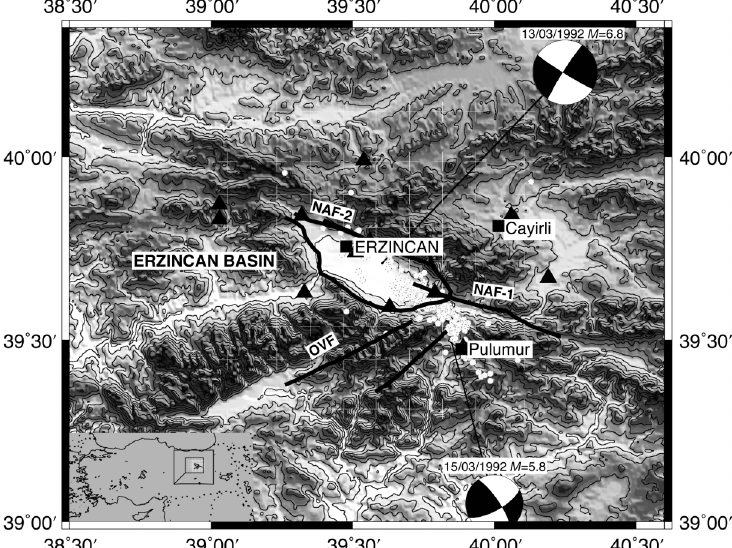
Fig. 1. Topographic map showing the Erzincan Basin and surrounding area. NAFZ, North Anatolian Fault Zone; OVF, Ovacik Fault. Epicenters (solid white circles) of the aftershocks of the 1992 March 13th Erzincan earthquake located by a temporary local seismic network (solid triangles). The focal mechanism for the Erzin- can earthquake and the largest aftershock (occurred near the Pülümür town) are taken from Fuenzalida et al. (1997). Hatched area denotes the study region and the grid net used in the inversion. The study area is also shown by rectangles in the small map of Turkey, lower